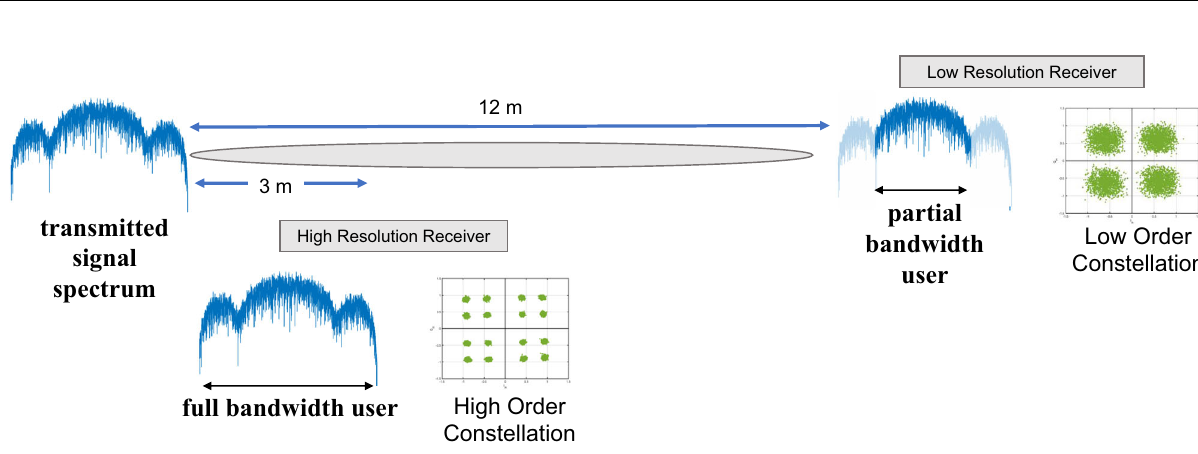
bandwidth of the transmitted signal, while more distant users, whose channel bandwidth is narrower, only employ the smaller range at the center of the spectrum.